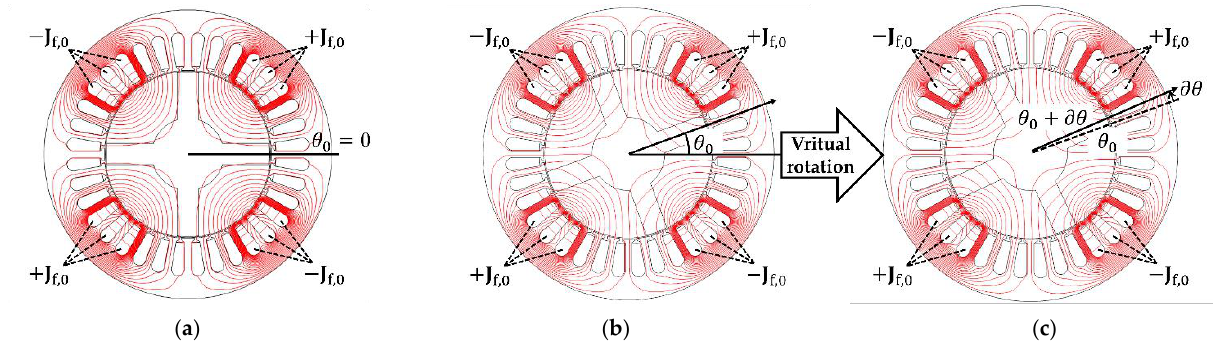
Figure 2. Virtual rotation of rotor of the experimental motor for Equation (5), with changes of magnetic flux; ( a ) the rotor is aligned at 𝜃 0 = 0 ; ( b ) before virtual rotation, the rotor is at 𝜃 0 ; ( c ) after virtual rotation, the rotor is 𝜕𝜃 away from 𝜃 0 in the CCW direction. The magnetic fluid, B , H , and co-energy also change accordingly. In this process, the current distribution 𝐉 f,0 is fixed. We use these figures in the Section 5 numerical analysis and experiment. Then, 𝐉 f,0 matched input current is used for Section 5, and specifications of the experimental motor are presented in Table A1.